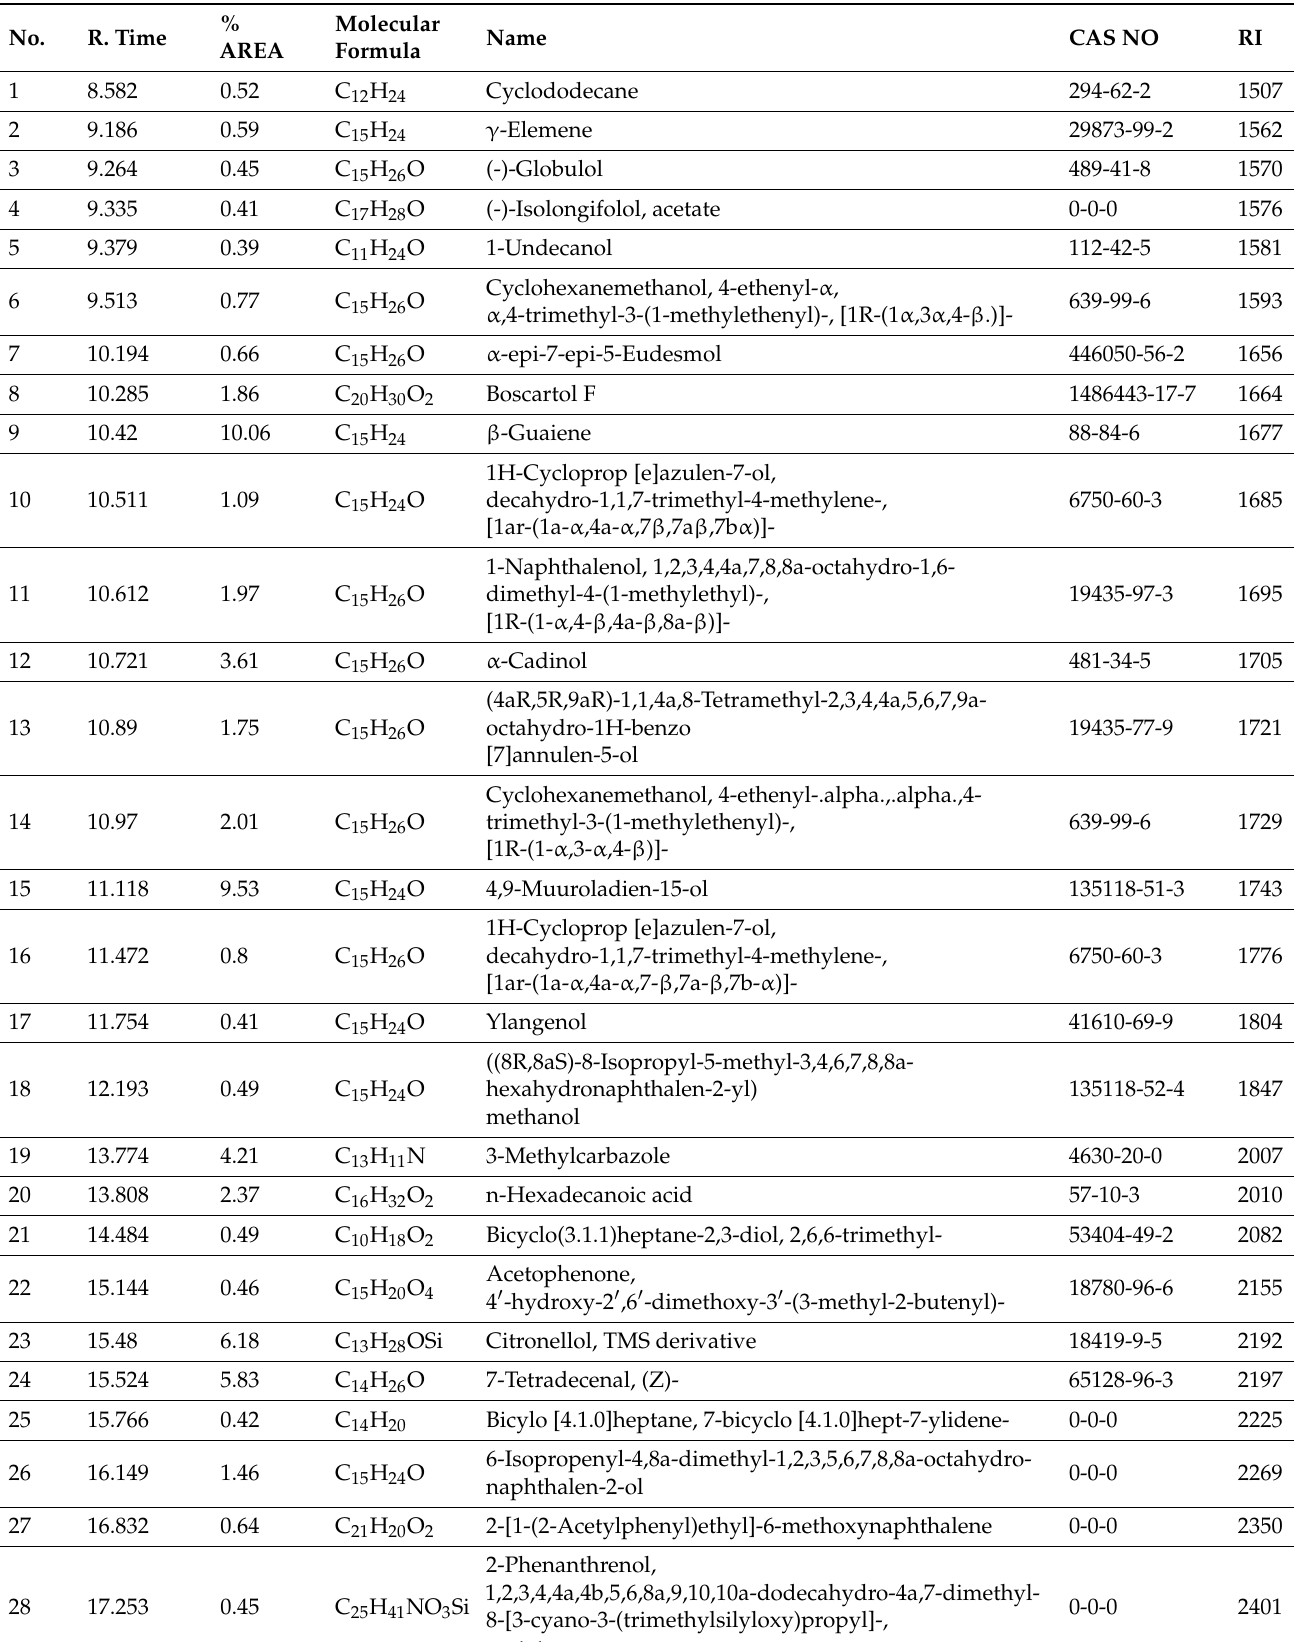
Table 12. Phytocompounds identified in isolated non-volatile oil C from the root bark of T. Ciliata by